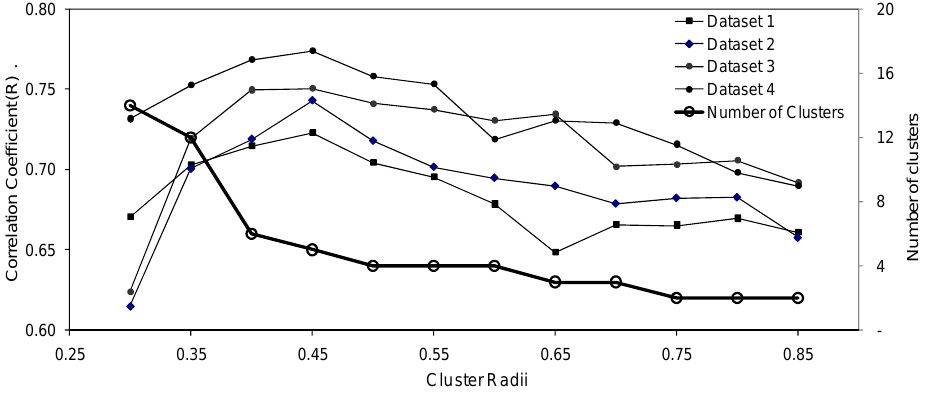
Figure 5. Effect of cluster radii on soil moisture retrieval accuracy for random datasets (SAR backscatter, NDVI and soil characteristics). The corresponding change in the number of clusters with radii is also